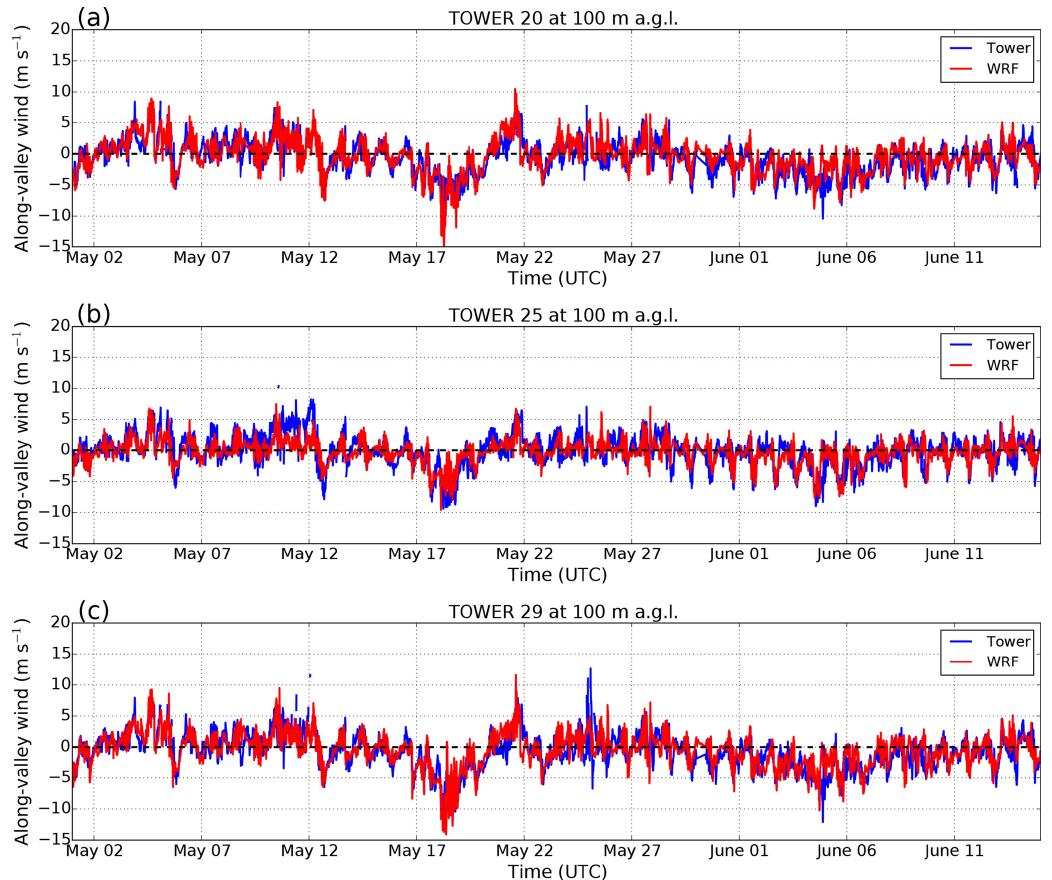
Figure 6. As in Fig. 5 but for the along-valley wind component.